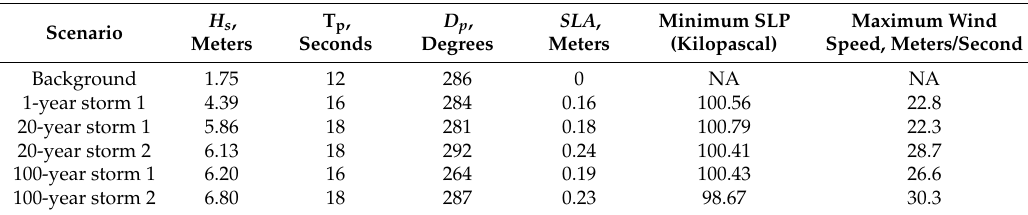
Figure 5. Map showing coastal regions that respond similarly to region-wide storms as determined through k-means clustering of nearshore total water level proxies [64]. Large colored arrows show the weighted mean offshore wave heights and winds for the 1-year, 20-year and 100-year return period coastal storms. Table 2. Boundary conditions associated with each modeled scenario.